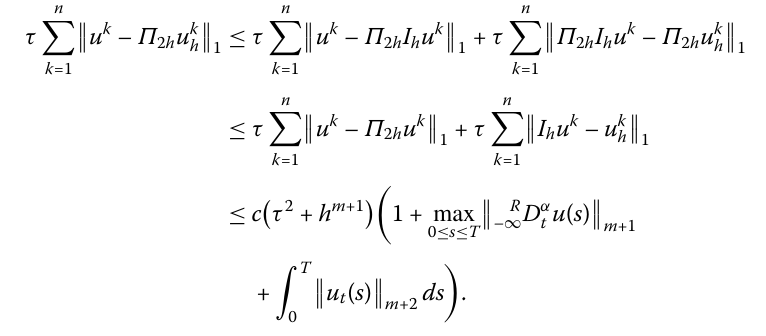
Table 3 Numerical errors and convergence orders in spatial direction with τ = 1 T = 1 for Example 1